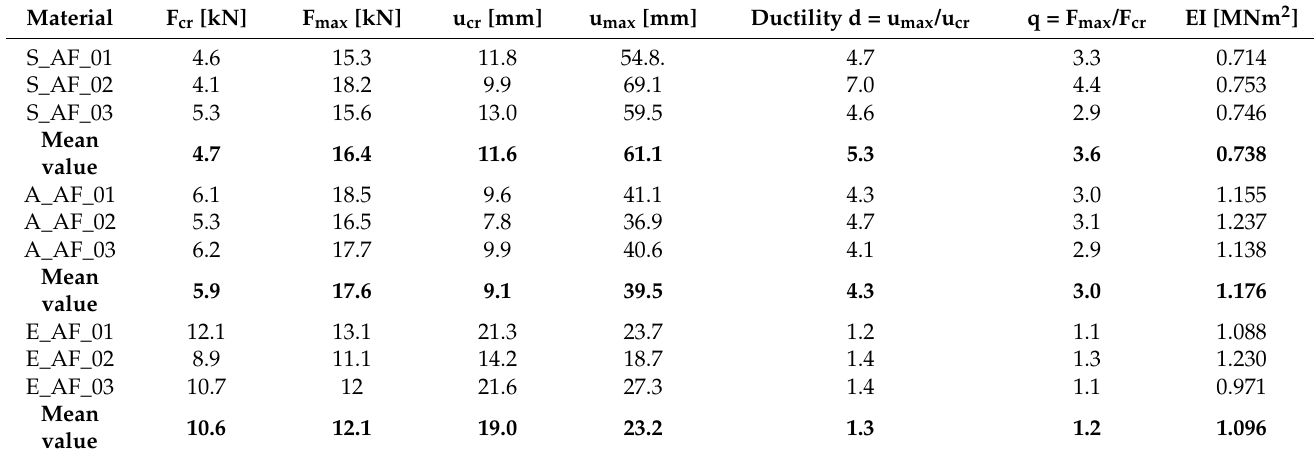
Table 7. Results of measurements for TGIB-fw with annealed float glass (AF).